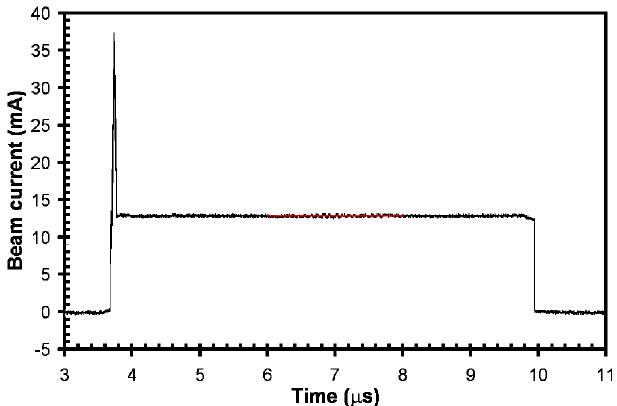
(cid:3) t (cid:4) . Shown is b